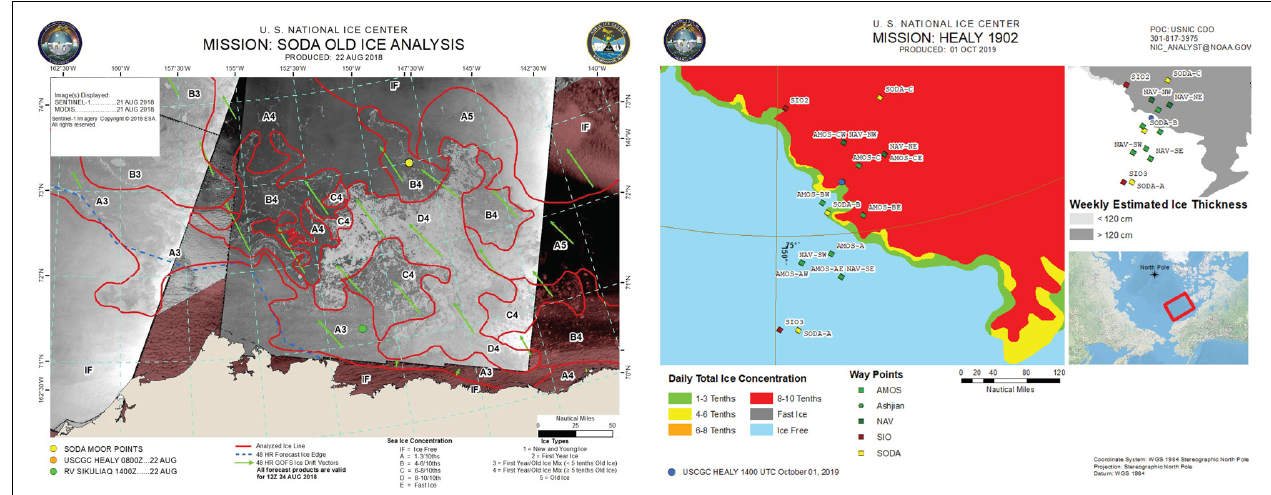
FIGURE 5 | (Left) Annotated image showing ice analysis from USNIC for August 22, 2018. Background is a mosaic of SAR images from RADARSAT-2 and Sentinel-1 (gray images), and visual (MODIS) images (pink to black images). (Right) USNIC ice analysis for October 01, 2019, showing ice types and estimated thickness around the SODA array during the recovery